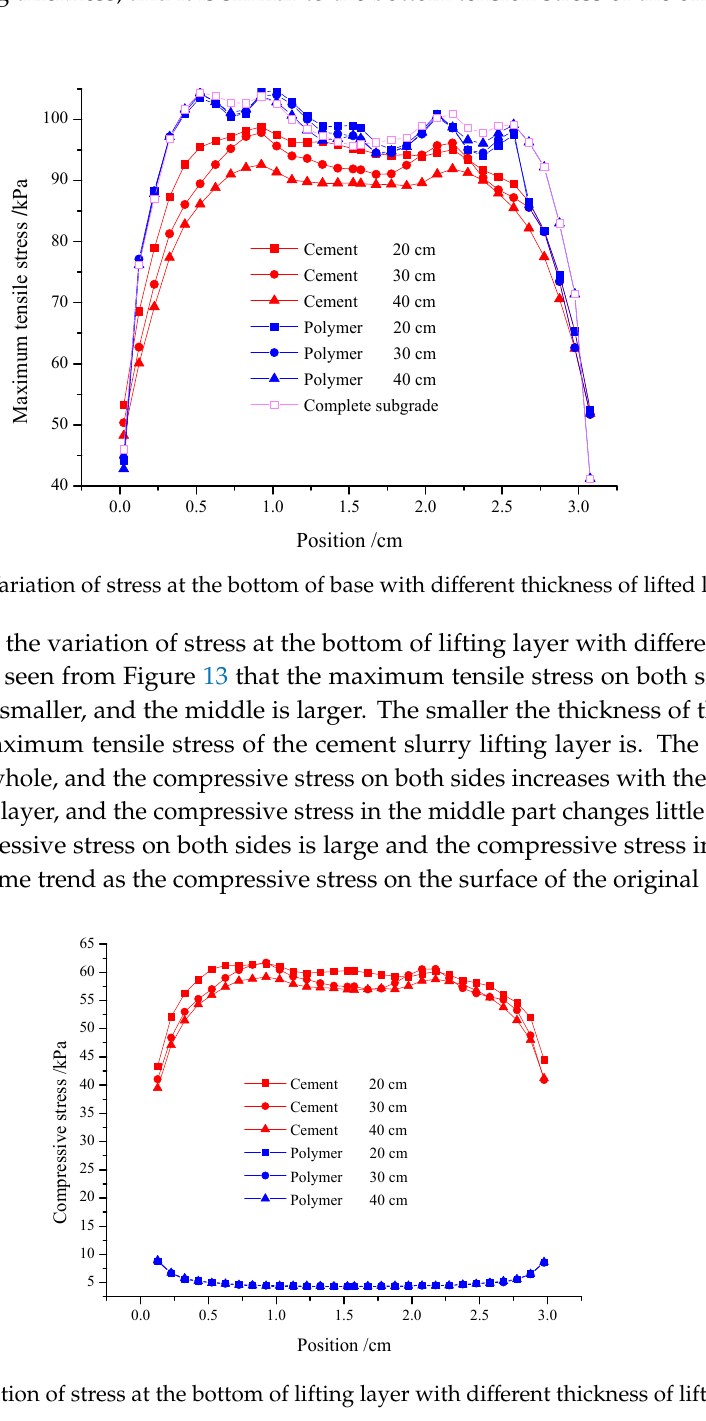
Figure 13. Variation of stress at the bottom of lifting layer with different thickness of lifted layer.